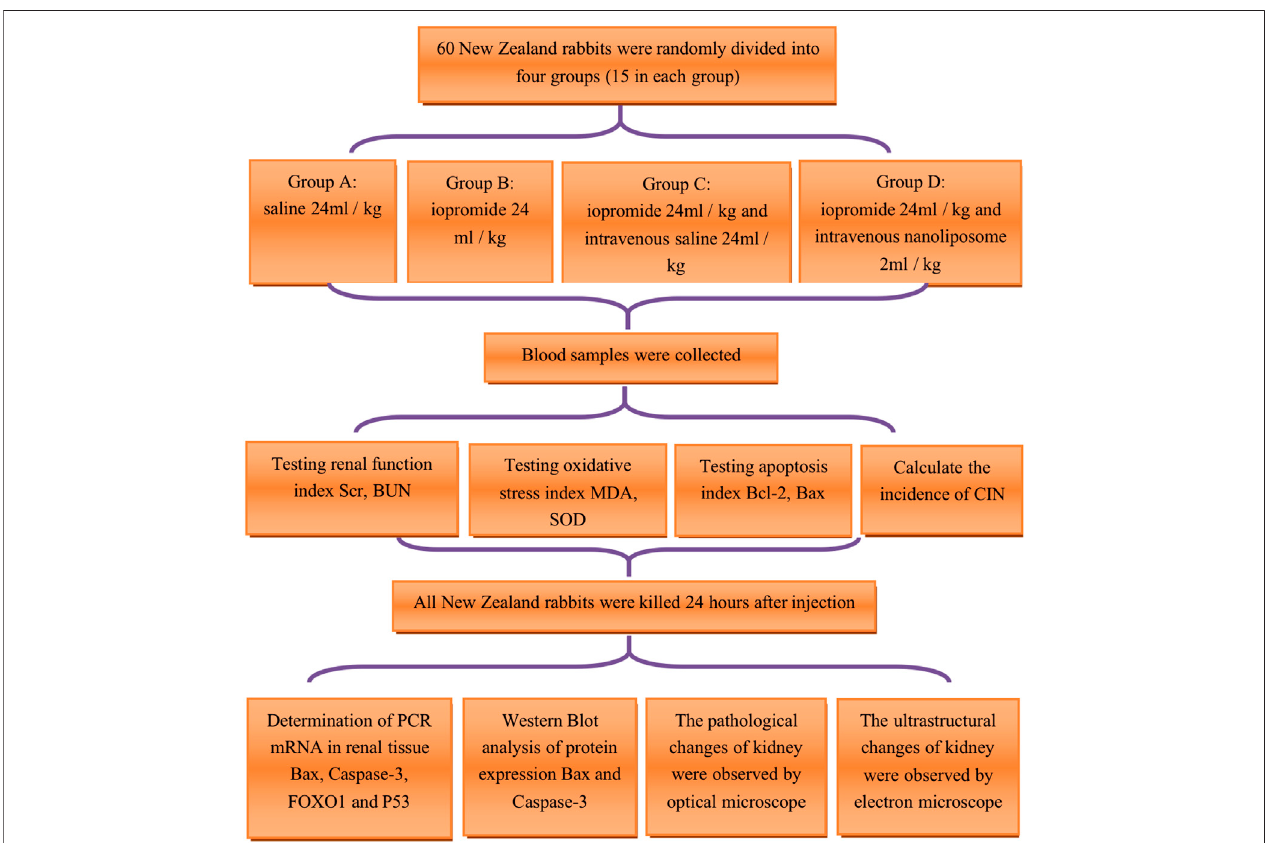
FIGURE 1 | Technology roadmap of animal experiment. Scr (cid:2) Serum creatinine; BUN (cid:2) blood urea nitrogen; MDA (cid:2) malondialdehyde; SOD (cid:2) superoxide dismutase; Bcl-2 (cid:2) B-cell lymphoma/leukemia 2; Bax: Bcl-2 subfamily, pro-apoptotic factor; CIN (cid:2) contrast Induced Nephropathy; Caspase-3 (cid:2) cysteine aspartate speci fi c protease 3; FOXO1 (cid:2) Forkhead box O1; P53: a apoptosis inducing